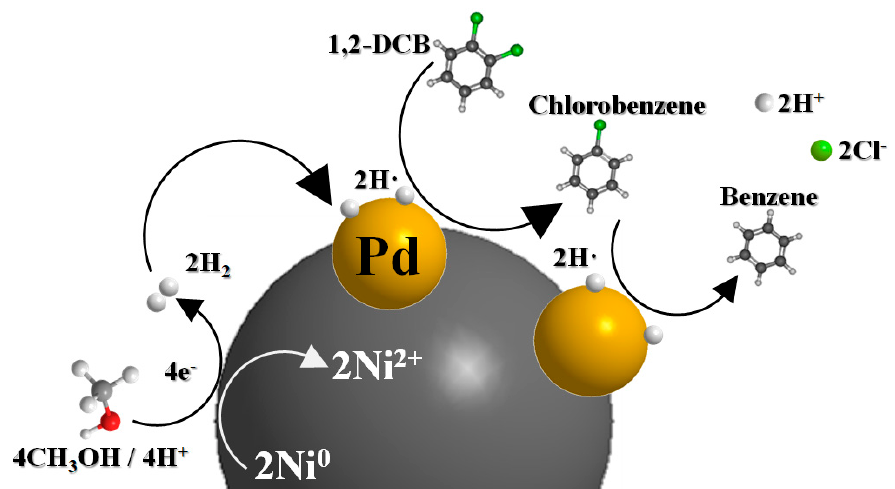
Figure 4. Schematic diagram of catalytic 1,2-DCB dechlorination on the surface of Ni/Pd bimetallic NPs.